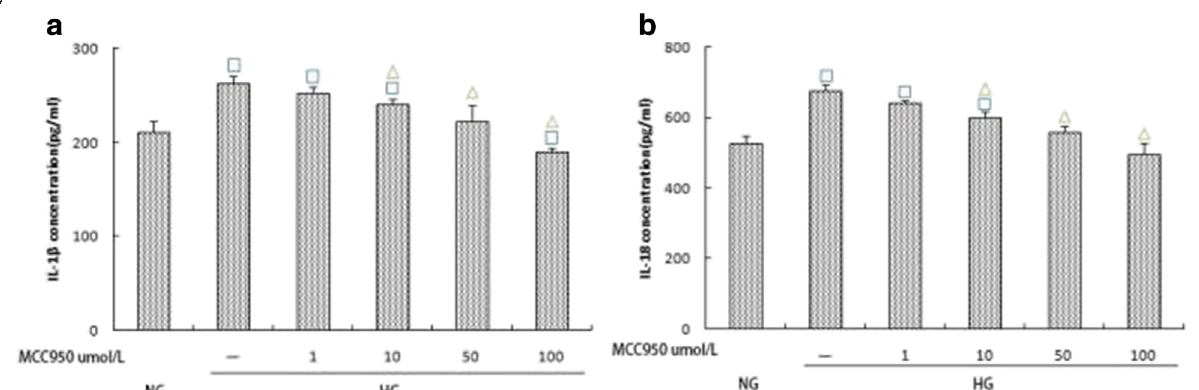
Fig. 6 a , b Effects of varying MCC950 concentrations (0,1,10,50 and 100 μ mol/L) on IL-1 β and IL-18 expression within the high glucose group. The protein levels of IL-1 β and IL-18 in culture supernatants were determined by ELISA. NG:normal control group,HG:high glucose group.Data are presented in mean ± SD, □ P < 0. 05 versus normal control group, △ P < 0. 05 versus high glucose group